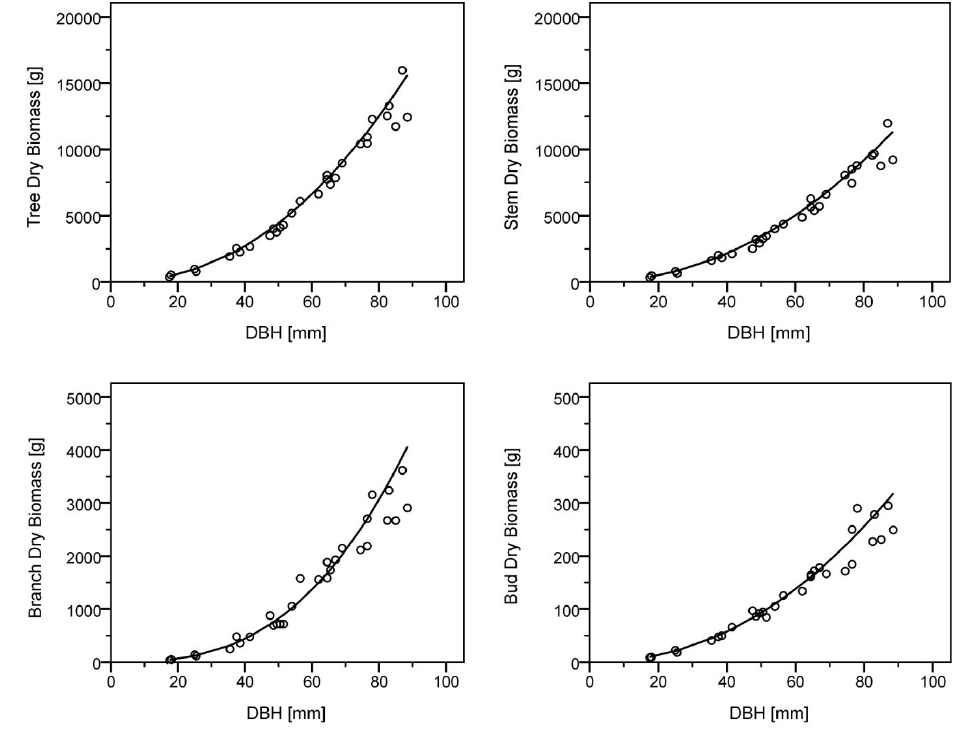
Figure 2. Biomass model for leafless above ground biomass (top left) and constituent tree parts, stem (top right), branch (bottom left), and bud (bottom right). Parameters of the model applicable to Equation 3 are shown in Table